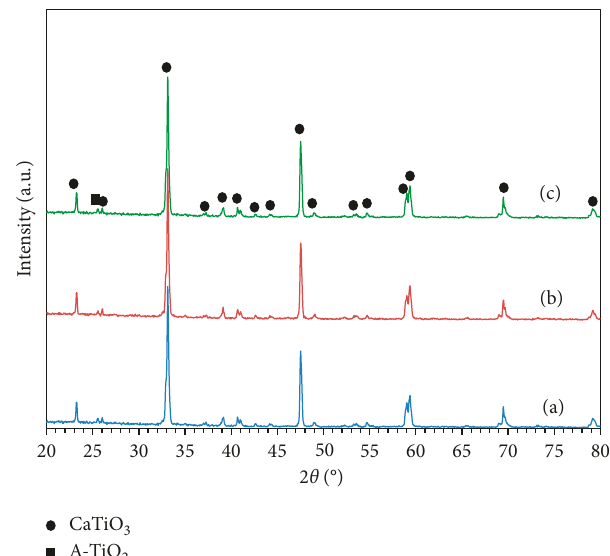
Figure 10: XRD patterns of calcium titanate ceramic sintered at 1350 ° C in air with different holding times (a) 60, (b) 120, and (c) 180min.